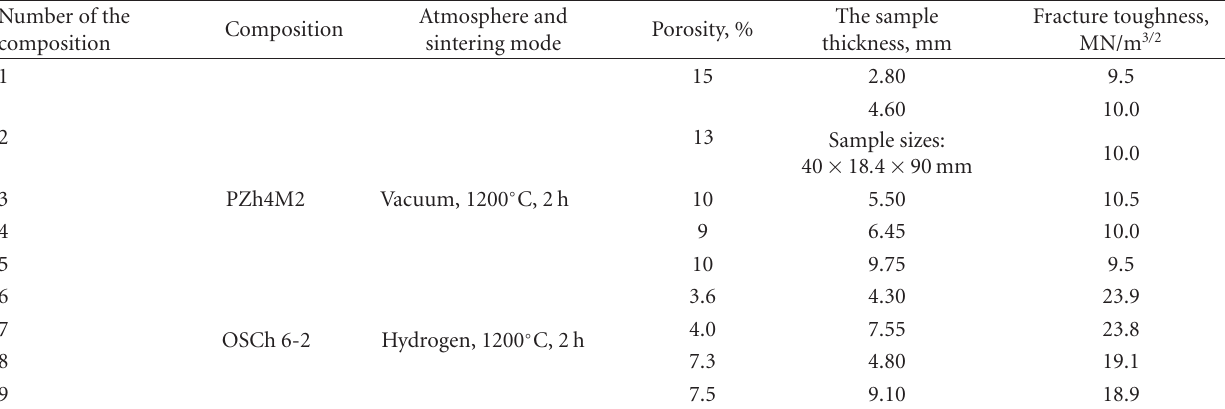
Table 1: The dependence of powder materials fracture toughness on porosity and sample thickness. Number of the